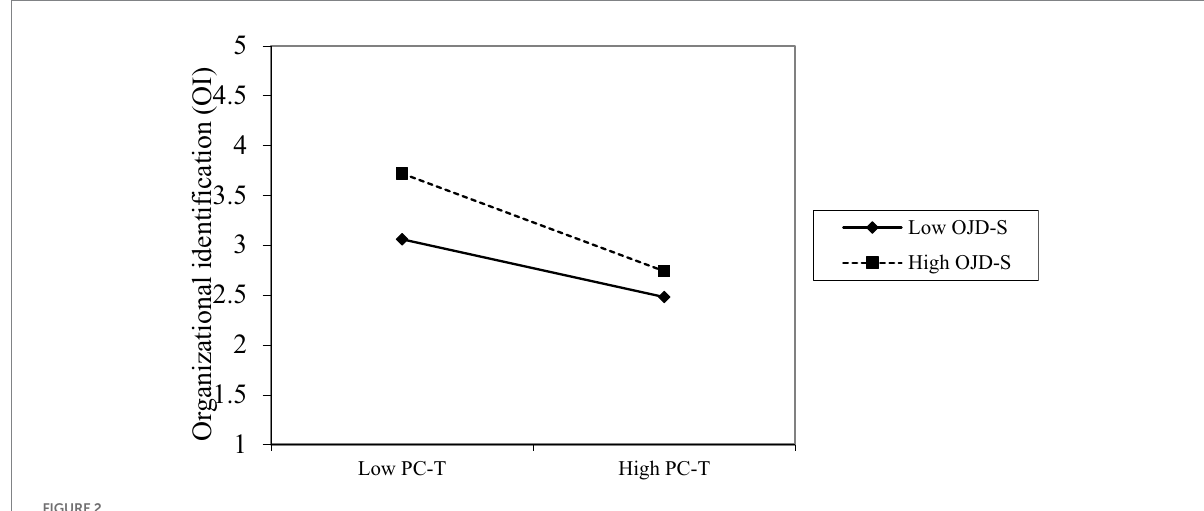
FIGURE 2 Simple slopes of the direct effect of PC-T to OI at high and low levers of